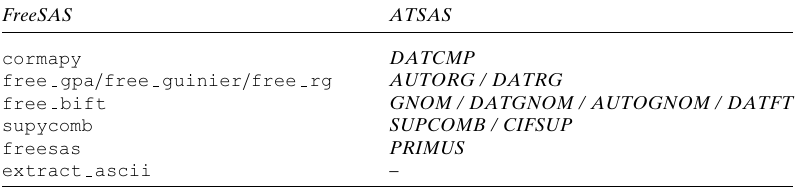
Table 1 ATSAS counterparts to command line programs provided by FreeSAS